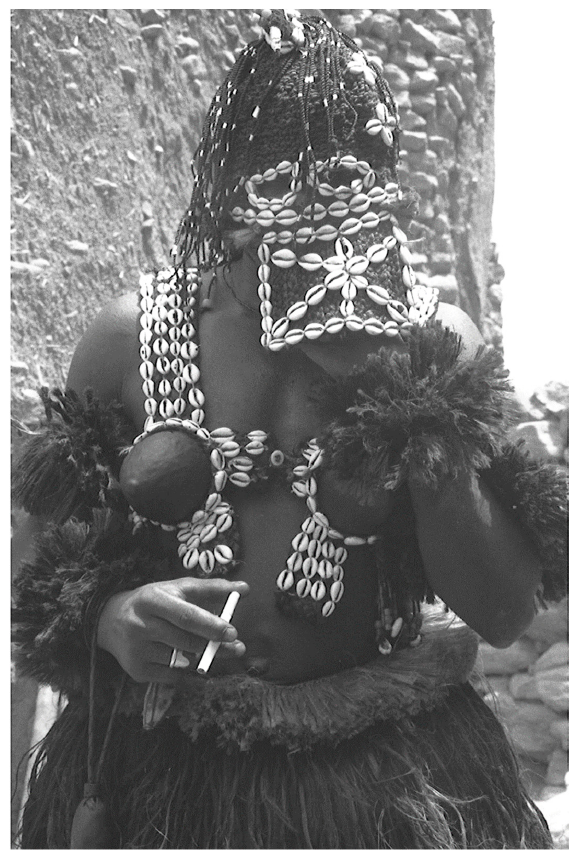
Figure 7. A stilt mask, having a smoke while resting.